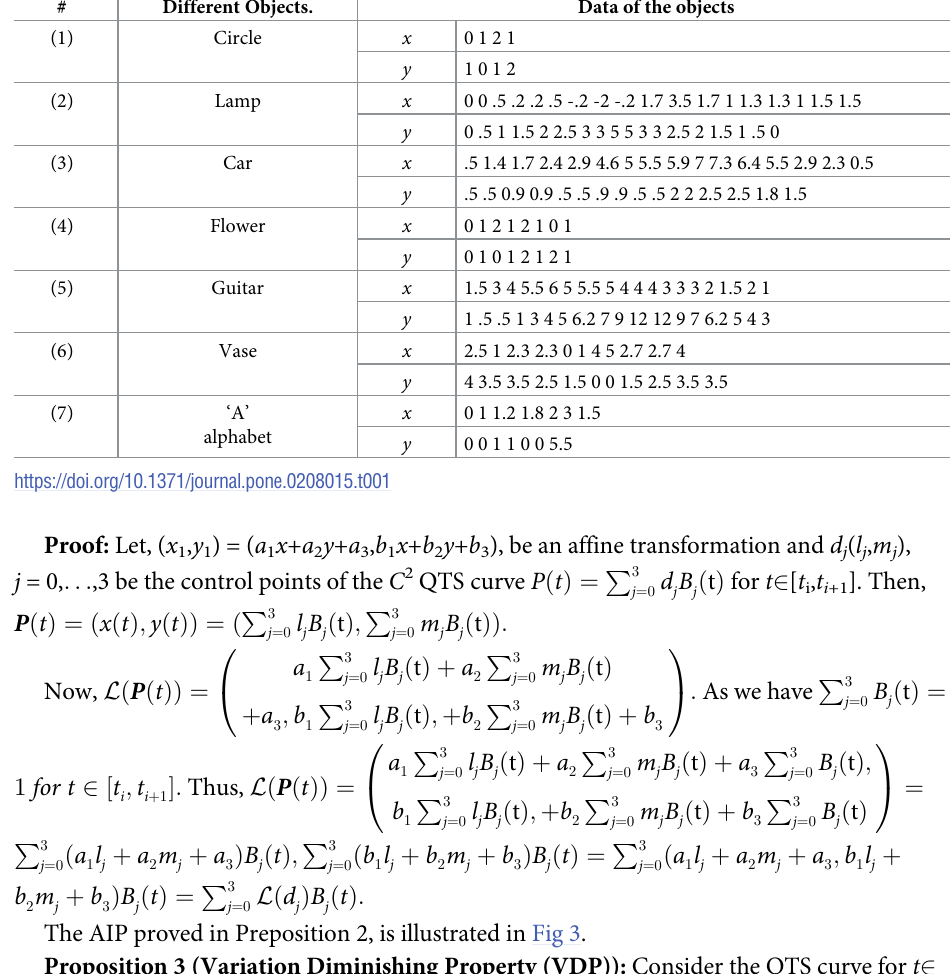
Table 1. Table of data of objects. # Different Objects.